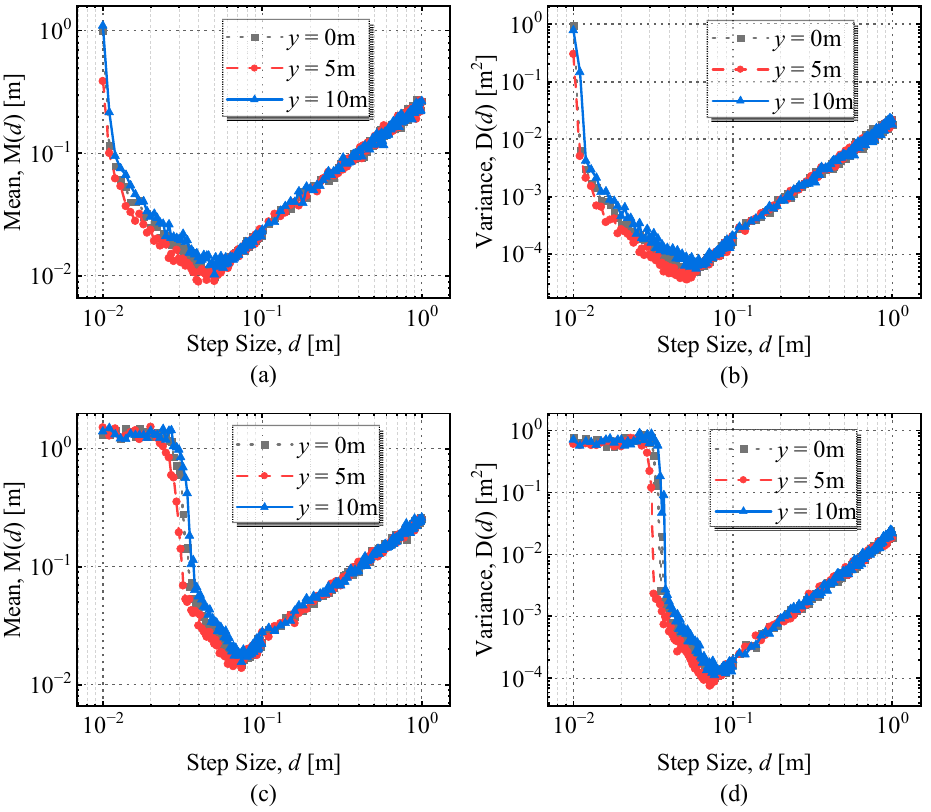
Figure 8. The expectation and variance of the main peak position error at the three conductors ( d = 0.01~1 m): ( a ) Expectation M ( d ) of the main peak position error at the second-order di ff erential; ( b ) Variance D ( d ) of the main peak position error at the second-order di ff erential; ( c ) Expectation M ( d ) of the main peak position error at the fourth-order di ff erential; ( d ) Variance D ( d ) of the main peak position error at the fourth-order di ff erential.